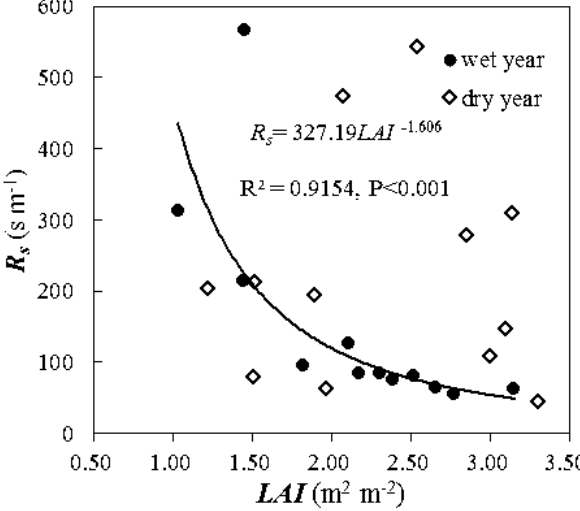
Figure 6. The relationship between leaf area index (LAI) and sur- face resistance ( R s ) during the growing season of the wet and dry